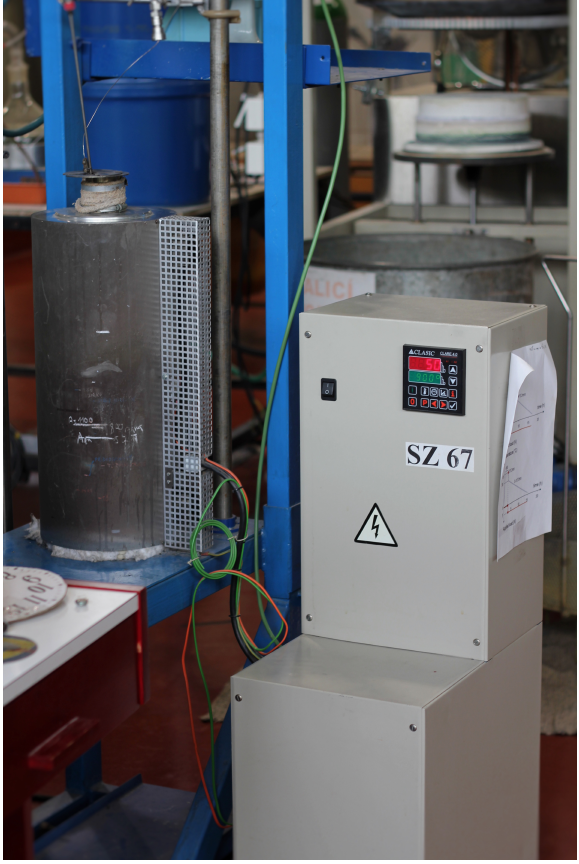
Figure 2. Burst-test experimental